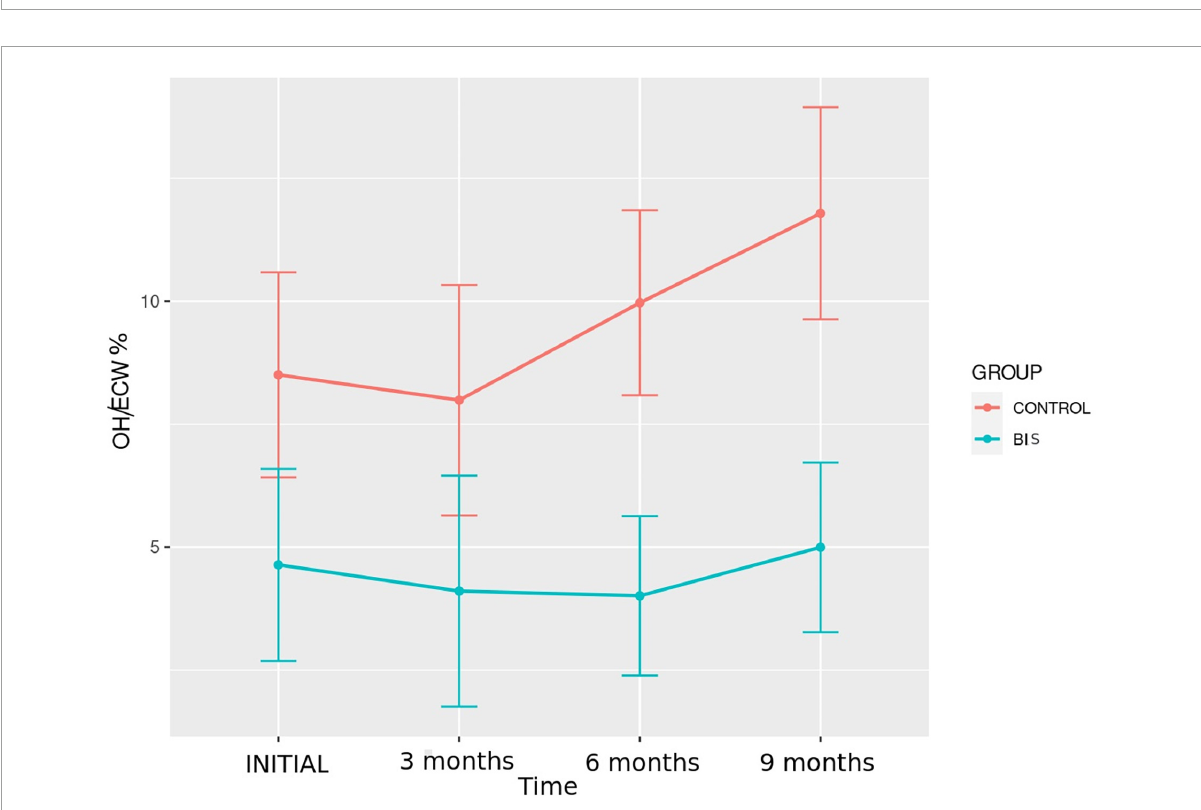
FIGURE3 Evolution of hydration status assessed by the OH/ECW% over time in the study